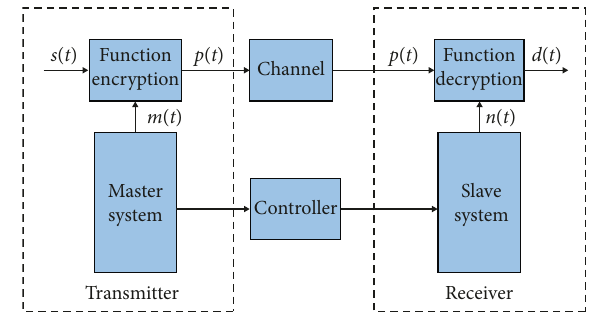
Figure 17: The schematic diagram of chaotic masking communication.